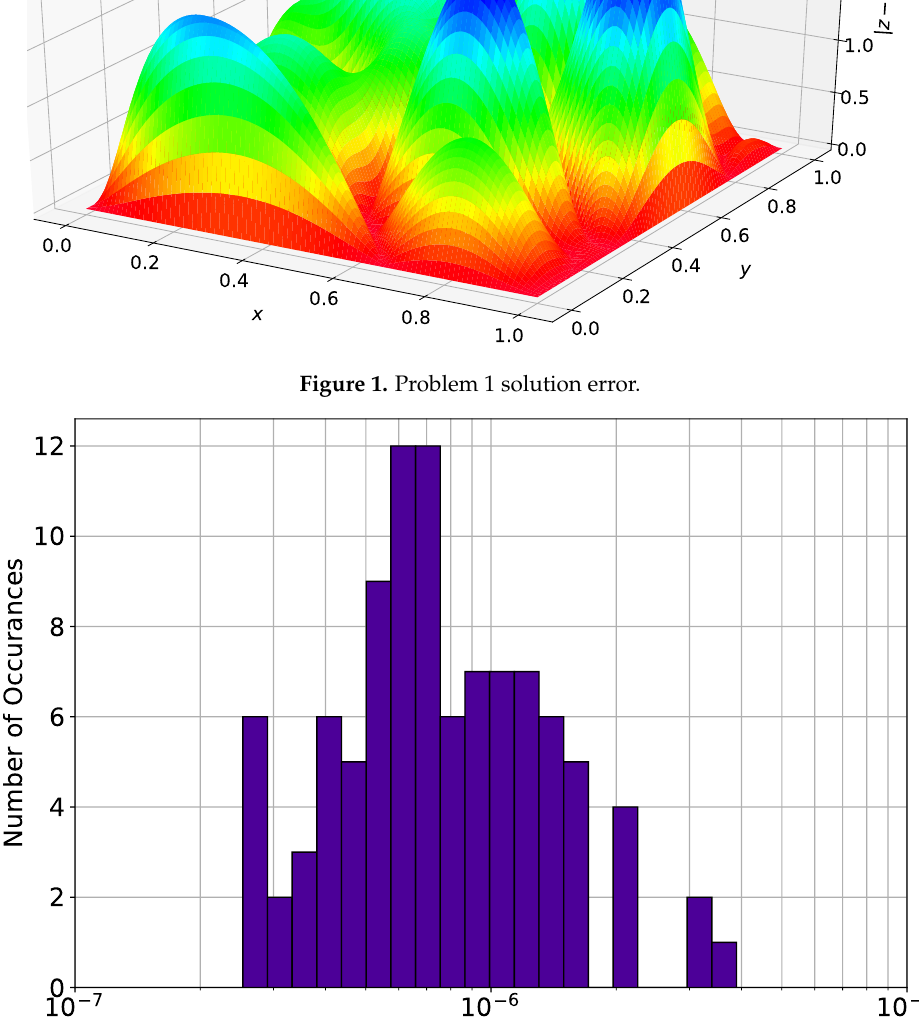
Figure 2. Problem 1 maximum test set solution error from 100 Monte Carlo